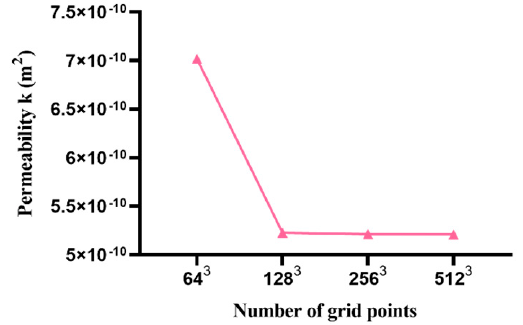
Figure 10. Effect of grid number on fluid permeability.